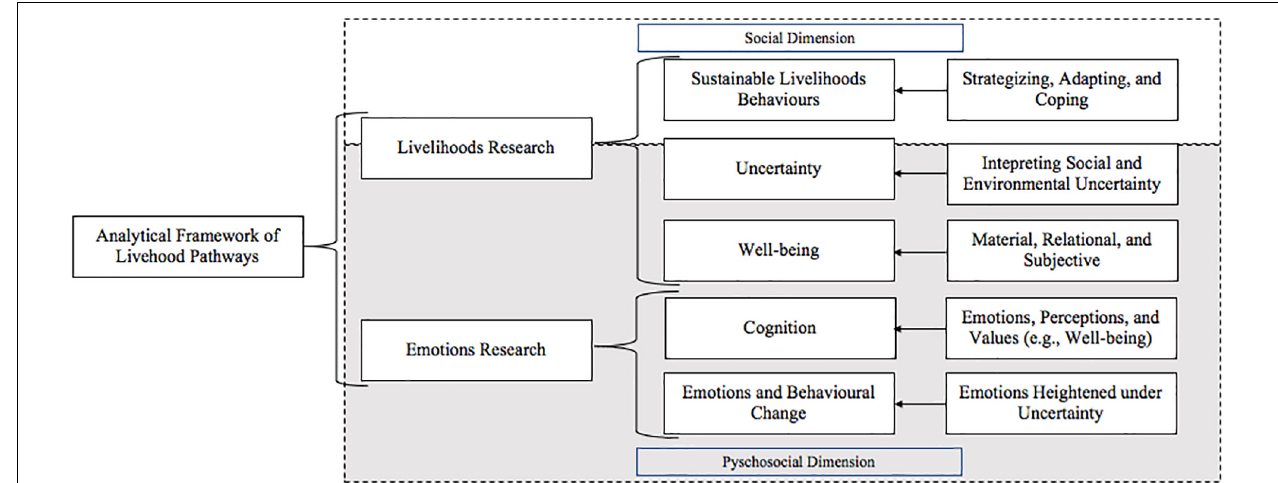
FIGURE 1 | An analytical